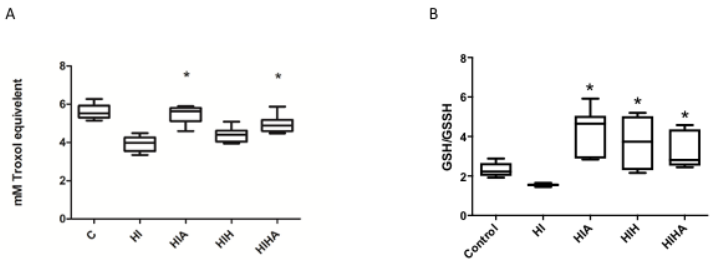
Figure 2. Antioxidant systems: ( A ) Box plot plasma ABTS levels; ( B ) Box plot plasma GSH/GSSG ratio. C: Control, HI: Hypoxia-ischemia, HIA: Hypoxia-ischemia + allopurinol, HIH: Hypoxia-ische- mia + hypothermia, HIHA: Hypoxia-ischemia + hypothermia + allopurinol. * p < 0.05 in post-hoc analysis compared to HI.